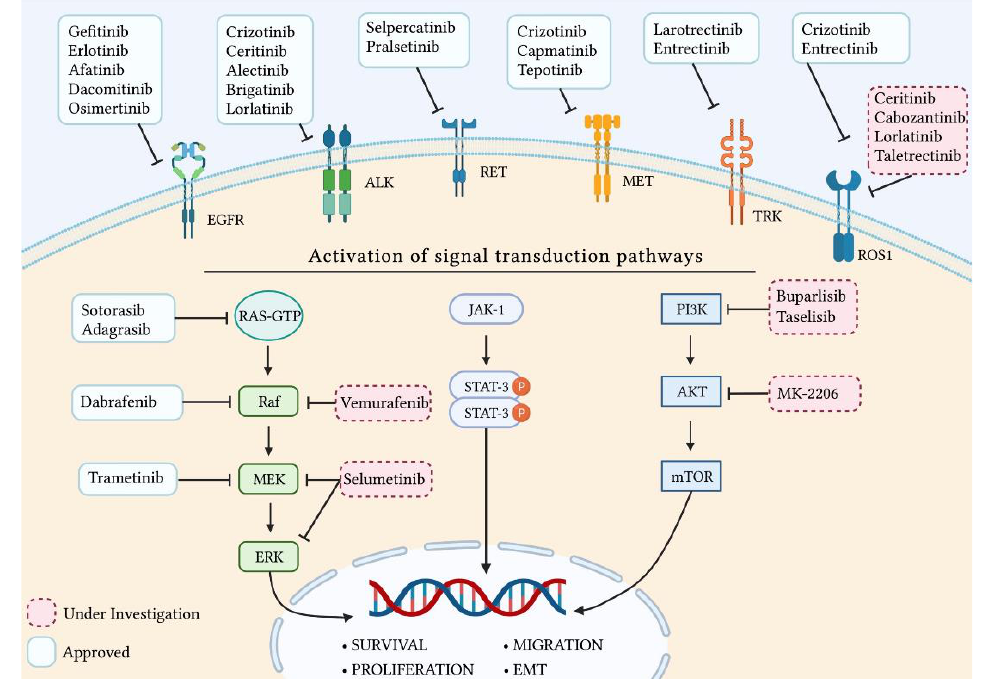
Figure 1. Targeted therapies: molecular targets and inhibited pathways. Protein kinase inhibitor targets are (1) membrane serine/threonine protein kinase: EGFR inhibitors, ALK inhibitors, RET inhibitors, MET inhibitors, NTRK inhibitors, and ROS1 inhibitors (from left to right); and (2) intracellular downstream proteins of the signal transduction pathways: KRAS inhibitors, RAF inhibitors, MEK-ERK inhibitors, PI3K inhibitor, and AKT inhibitor. The inhibition of both membrane and intracellular targets leads to the inhibition of the following pathways: (1) MAPKs (left column: RAS-GTP, Raf, MEK, ERK), (2) JAK/STAT (middle column: JAK-1, STAT3), and (3) PI3K/AKT (right column: PI3K, AKT, mTOR). Blue boxes indicate FDA-approved drugs, red dotted boxes indicate drugs under investigation (not yet approved for clinical